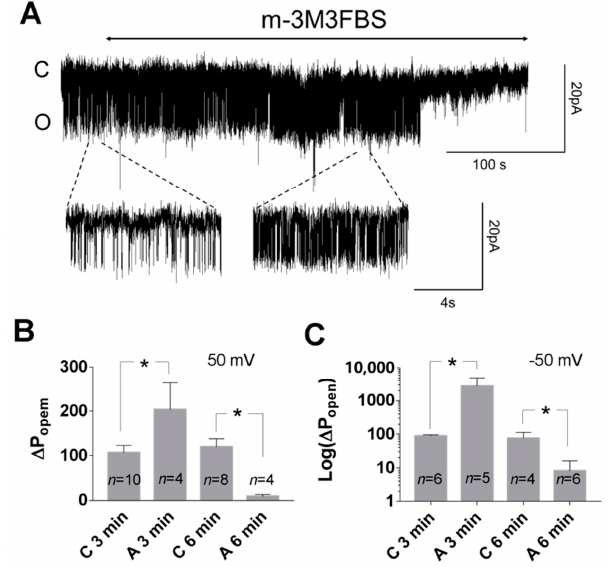
Figure 5. Effect of the PLC activator (m ‐ 3M3FBS) on TREK ‐ 2 like channel activity in the cell ‐ attached configuration. ( A ) Original trace showing the action of the PLC activator (25 μ M) on the activity of the TREK ‐ 2 ‐ like channel at − 50 mV. A temporary increase in the activity after about 3 min of m ‐ 3M3FBS administration is visible in the right expanded fragment of the upper trace. ( B,C ) The col ‐ umns represent normalized P open after 3 minutes in the control solution (C 3min ) or the PLC activator (A 3min ) and after 6 minutes in the control solution (C 6min ) or in the PLC activator (A 6min ): 100% activity was attributed to the P open at the beginning of recording in the control solution (P open at 0 min). C 3min and A 3min represents (cid:2900)(cid:2925)(cid:2926)(cid:2915)(cid:2924) (cid:2911)(cid:2930) (cid:2871) (cid:2923)(cid:2919)(cid:2924) (cid:2900)(cid:2925)(cid:2926)(cid:2915)(cid:2924) (cid:2911)(cid:2930) (cid:2868) (cid:2923)(cid:2919)(cid:2924) ∗100% , and C 6min and A 6min represent (cid:2900)(cid:2925)(cid:2926)(cid:2915)(cid:2924) (cid:2911)(cid:2930) (cid:2874) (cid:2923)(cid:2919)(cid:2924) (cid:2900)(cid:2925)(cid:2926)(cid:2915)(cid:2924) (cid:2911)(cid:2930) (cid:2868) (cid:2923)(cid:2919)(cid:2924) ∗100% in the control solution or in the presence of the PLC activator, respectively: ( B ) 50 mV, C 3min vs. A 3min * p = 0.039, C 6min vs. A 6min * p = 0.033; Bonferroni’s multiple comparison test; ( C ) − 50 mV, C 3min vs. A 3min * p = 0.045, C 6min vs. A 6min * p = 0.048, Mann–Whitney test. In all experiments, the bath solution contained Ca 2+ (0.1 or 1.7